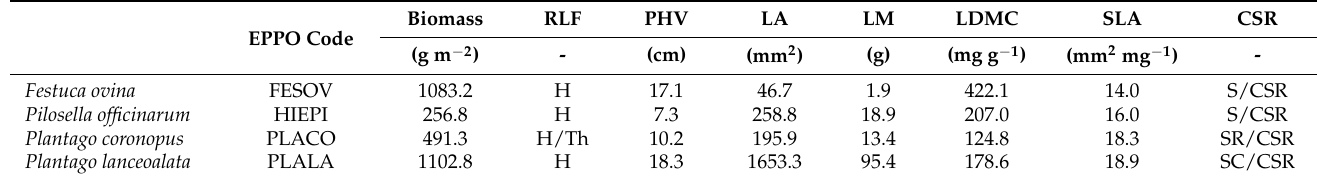
Table 2. Traits of the plant species used as living mulches. Trait data have been compiled from FAWC Database [6]. Biomass estimation is described in Appendix A. RLF, Raunkiær life form; PHV, plant height (vegetative); LA, leaf area; LM, leaf mass; LDMC, leaf dry matter content, SLA, specific leaf area; CSR, plant CSR strategy according to Hodgson et al.